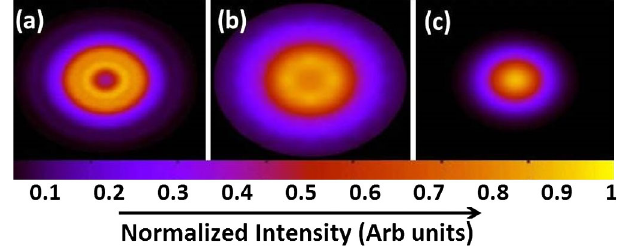
FIG. 12. Mode profiles from the simulations at a wavelength of 10 μ m, for a hole size of 1 mm, for the (a) confocal ( g ¼ 0 ), (b) concentric ( g ¼ − 1 ) and (c) intermediate ( g ¼ − 0 . 6 ) con- figurations. For each plot the window size is 50 mm by 50